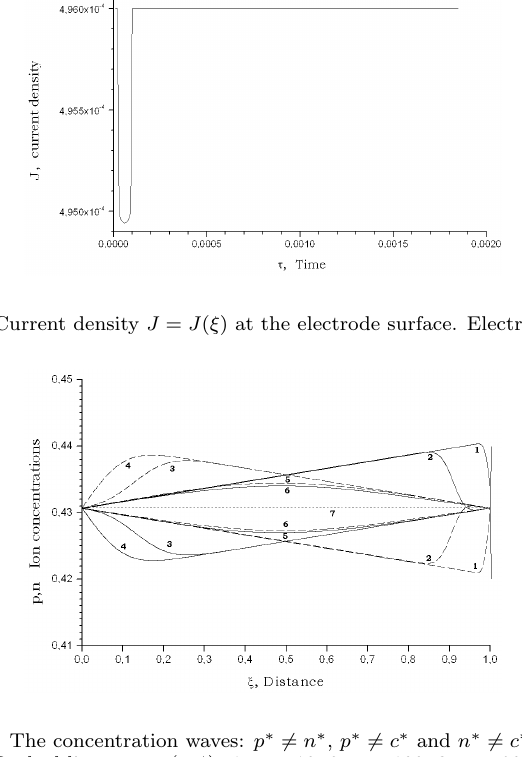
Figure 3. The concentration waves: p ∗ (cid:54) = n ∗ , p ∗ (cid:54) = c ∗ and n ∗ (cid:54) = c ∗ . Solid line: p = p ( τ,ξ ). Dashed line: n = n ( τ,ξ ). 1: τ = 10, 2: τ = 100, 3: τ = 900, 4: τ = 100, 5: τ = 9000, 6: τ = 10000, 7: